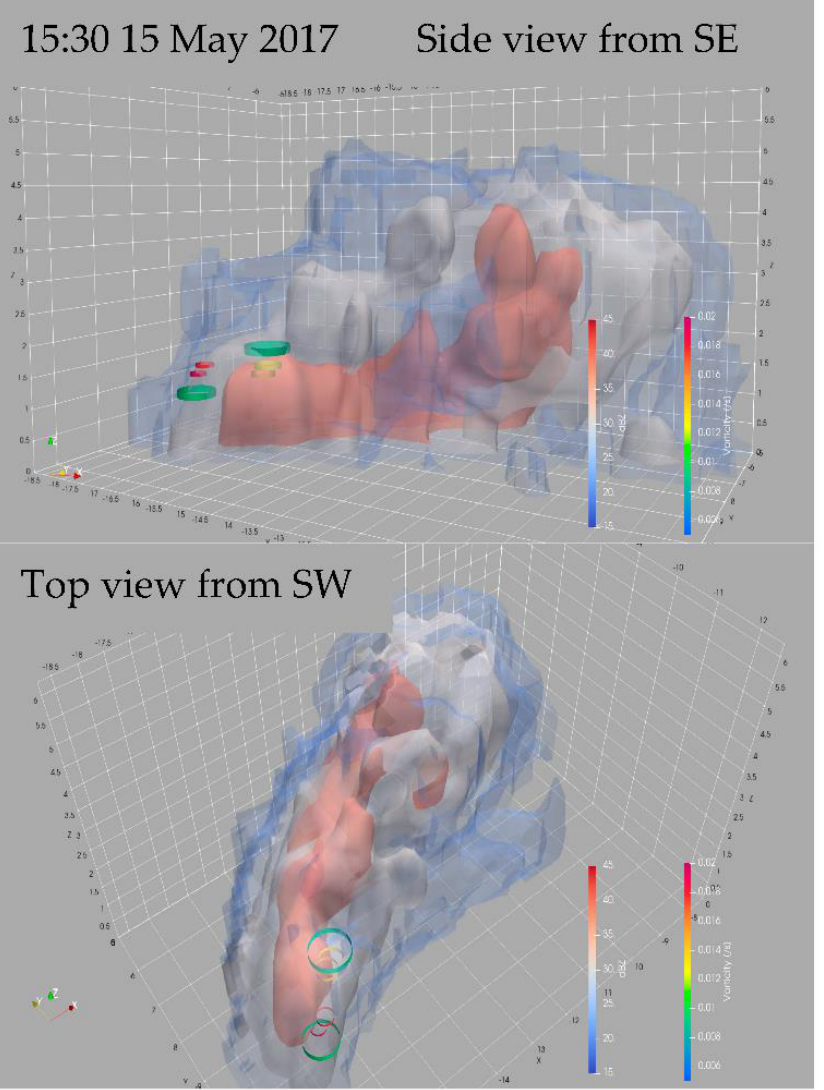
Figure 4. Three-dimensional view: (( top ) side view from southeast, ( bottom ) top view from south- west) of the radar echo from PAWR at 15:30 JST on 15 May 2017. Circles in this figure show the location, size, and vorticity of the misocyclones estimated from the Doppler velocity data of